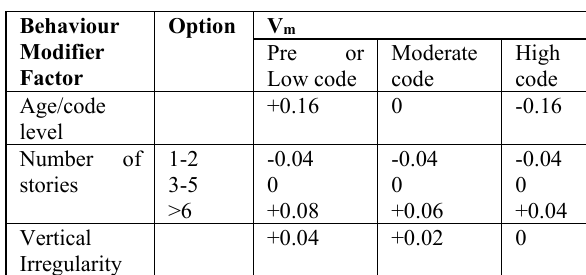
Table 4 . Behaviour Modifier Factors for RC buildings.